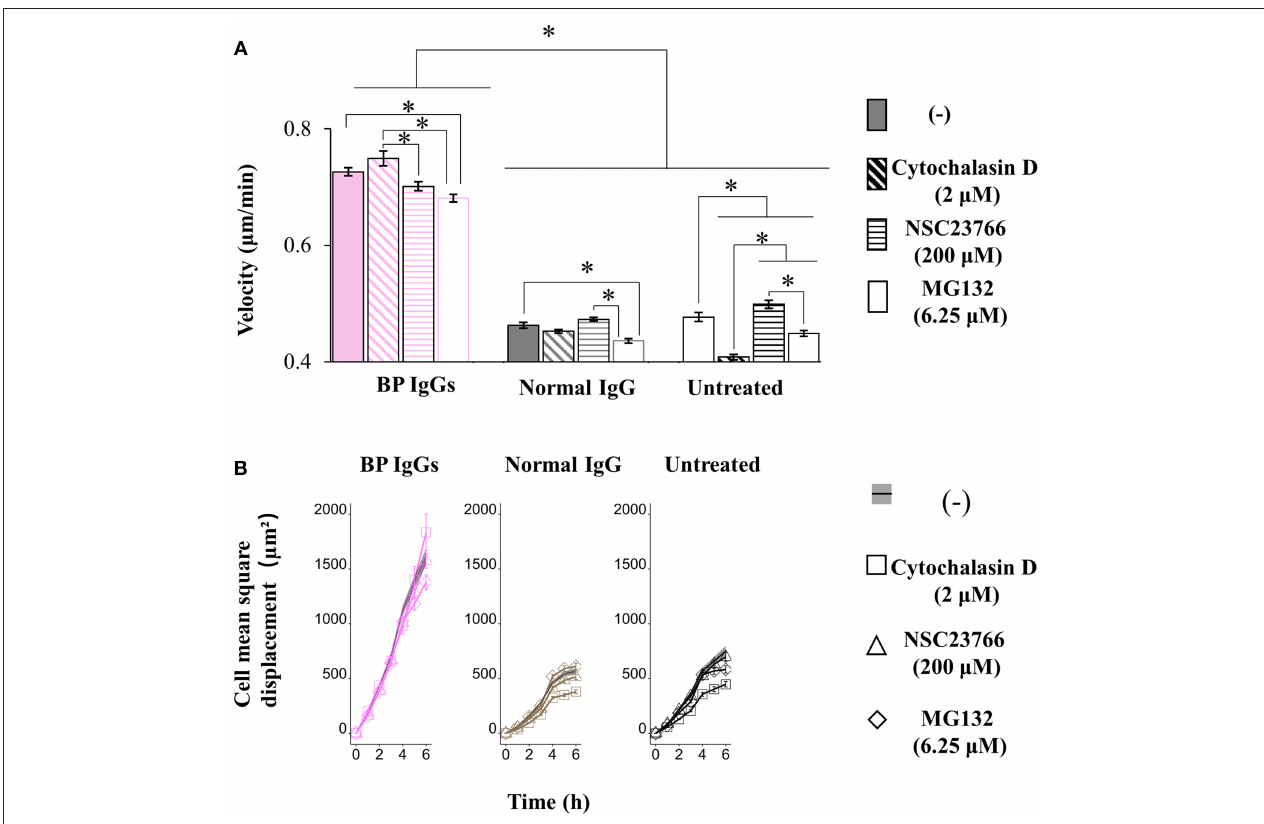
FIGURE 12 | Effects of cytochalasin D, NSC237766, and MG132 on the BP IgG-induced increase in cell motility. NHEKs were pretreated with cytochalasin D (2 µ M) for 30min, NSC23766 (200 µ M) for 1h, or MG132 (6.25 µ M) for 0h, and then 2 mg/ml BP IgGs (BP-1, BP-2, BP-3) or normal IgG were incubated with the cultured cells for 6h. (A) Velocity of the NHEKs stimulated with IgGs. One-way ANOVA was used for the statistical analysis. *: p -value < 0.05. (B) Mean square displacement of the NHEKs stimulated with